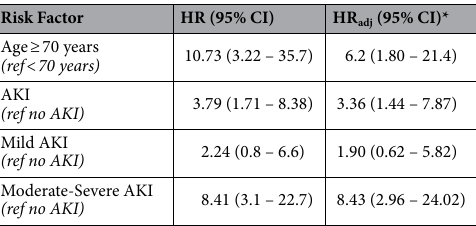
Risk Factor HR (95%